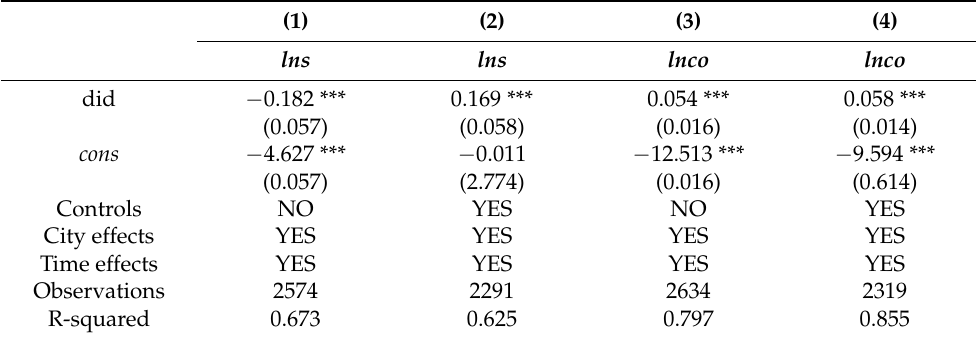
Table 3. The impact of provincial